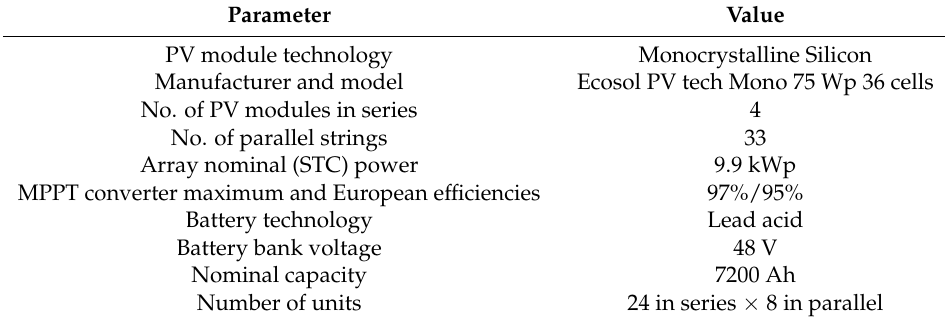
Table 3. The main parameters of the central PV system from the final PVsyst